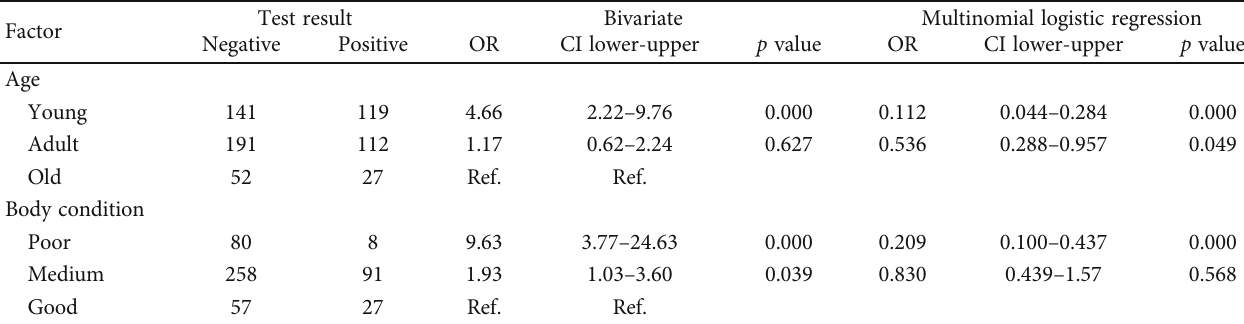
Table 4: Multivariable analysis of potential risk factors associated to